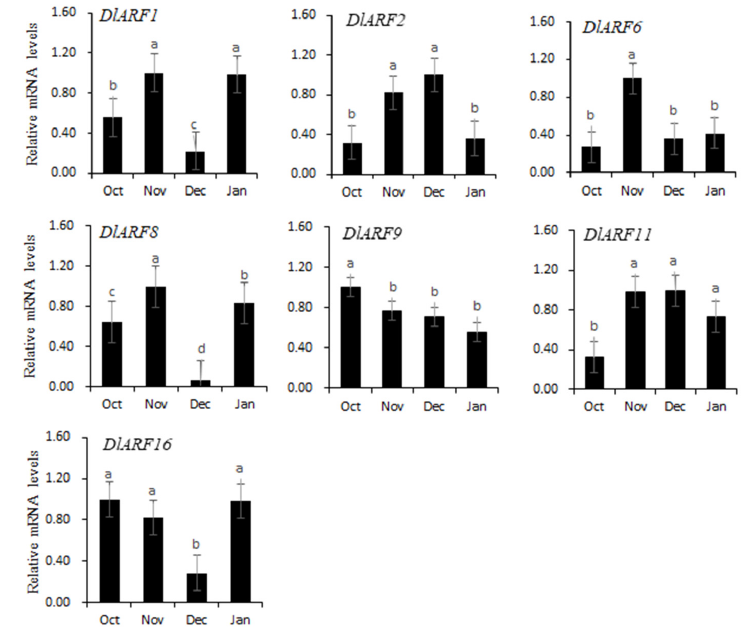
Figure 7. Expression patterns of seven DlARF genes during floral bud physiological differentiation of longan. The x-axis indicates months and the y-axis indicates the relative gene expression. Values with the different letter (a, b, c) were significantly different when assessed using Duncan’s multiple range test ( p < 0.05)